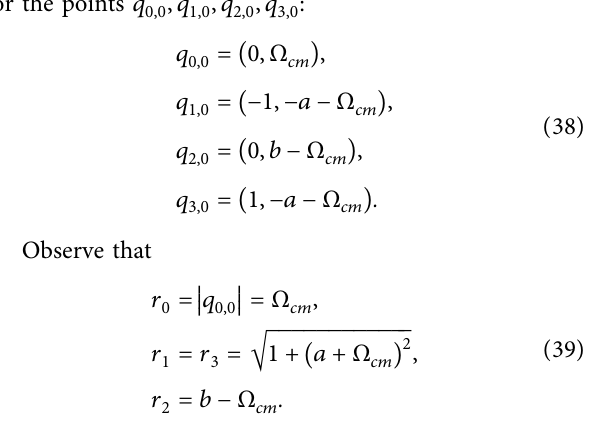
( a ) in the region of central 0